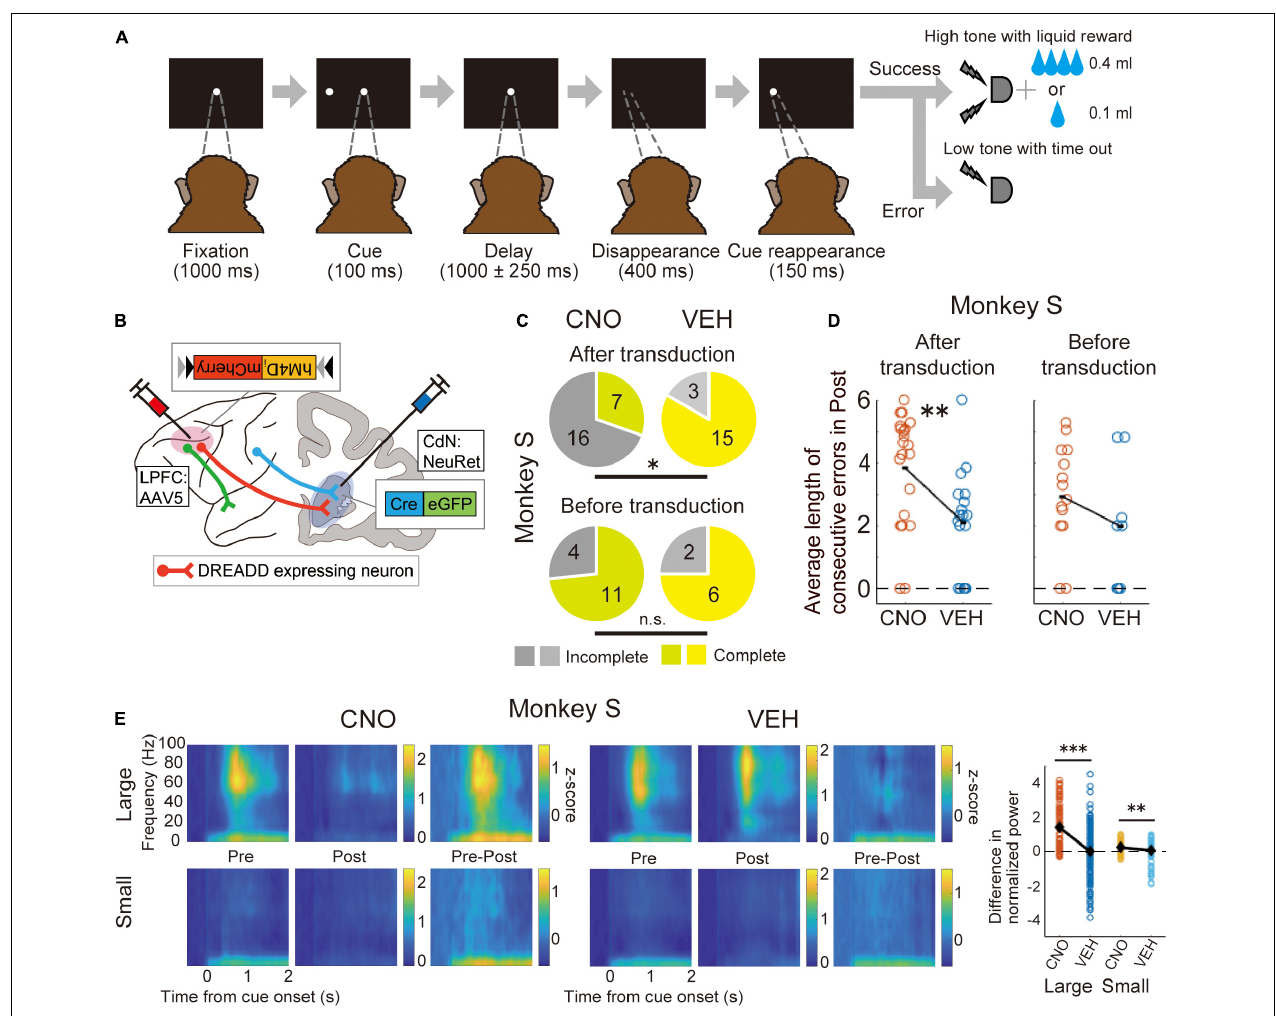
FIGURE 1 | Chemogenetic manipulation of the LPFC-CdN pathway with double-viral vector transduction. (A) Time sequence of the one-direction reward (1DR) memory-guided saccade task. The monkeys had to memorize whether the cue was presented to the left or right, and then made a saccade in that direction after the delay period. The allocation of large and small rewards to the left and right changed randomly block by block. (B) Illustration of the chemogenetic double transduction. Only doubly transduced neurons whose cell bodies were in the LPFC and axon terminals in the CdN expressed DREADDs. (C) Proportion of complete and incomplete sessions before (top) and after (down) double transduction compared between CNO and vehicle (VEH) conditions in one monkey. Yellowish colors indicate complete sessions, and grayish colors indicate incomplete sessions. ∗ P < 0.05, ∗∗ P < 0.01, ∗∗∗ P < 0.001, n.s., non-significant. (D) Average length of consecutive errors during the last 160 trials before the end of sessions. Each dot indicates the average length of consecutive errors per session. (E) Spectrograms of LFPs recorded from the LPFC divided into large and small reward trials in the CNO and VEH conditions. Pre: The first 160 trials, Post: The last 160 trials, Pre–Post: their subtraction. Color represents normalized power. Time 0 refers to the cue onset. The most right panel shows comparisons between CNO and VEH conditions of the difference in power (Pre-Post) in the time-frequency domain where the cue response was observed. Each dot refers to the subtracted power from each electrode channel. Black diamonds represent mean values. Reproduced with permission from Oguchi et al.